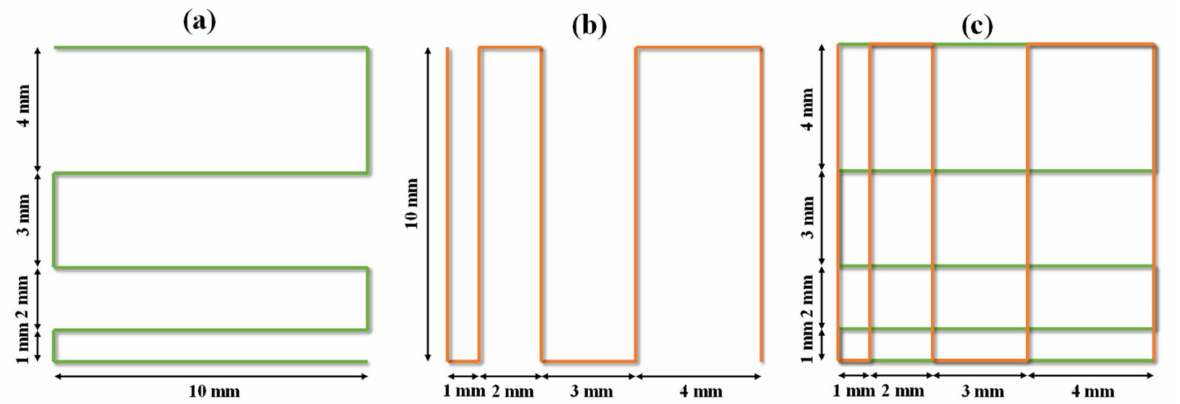
Figure 1. Filament fusion testing pattern printed along: ( a ) 1st layer, ( b ) 2nd layer, and ( c ) final pattern.